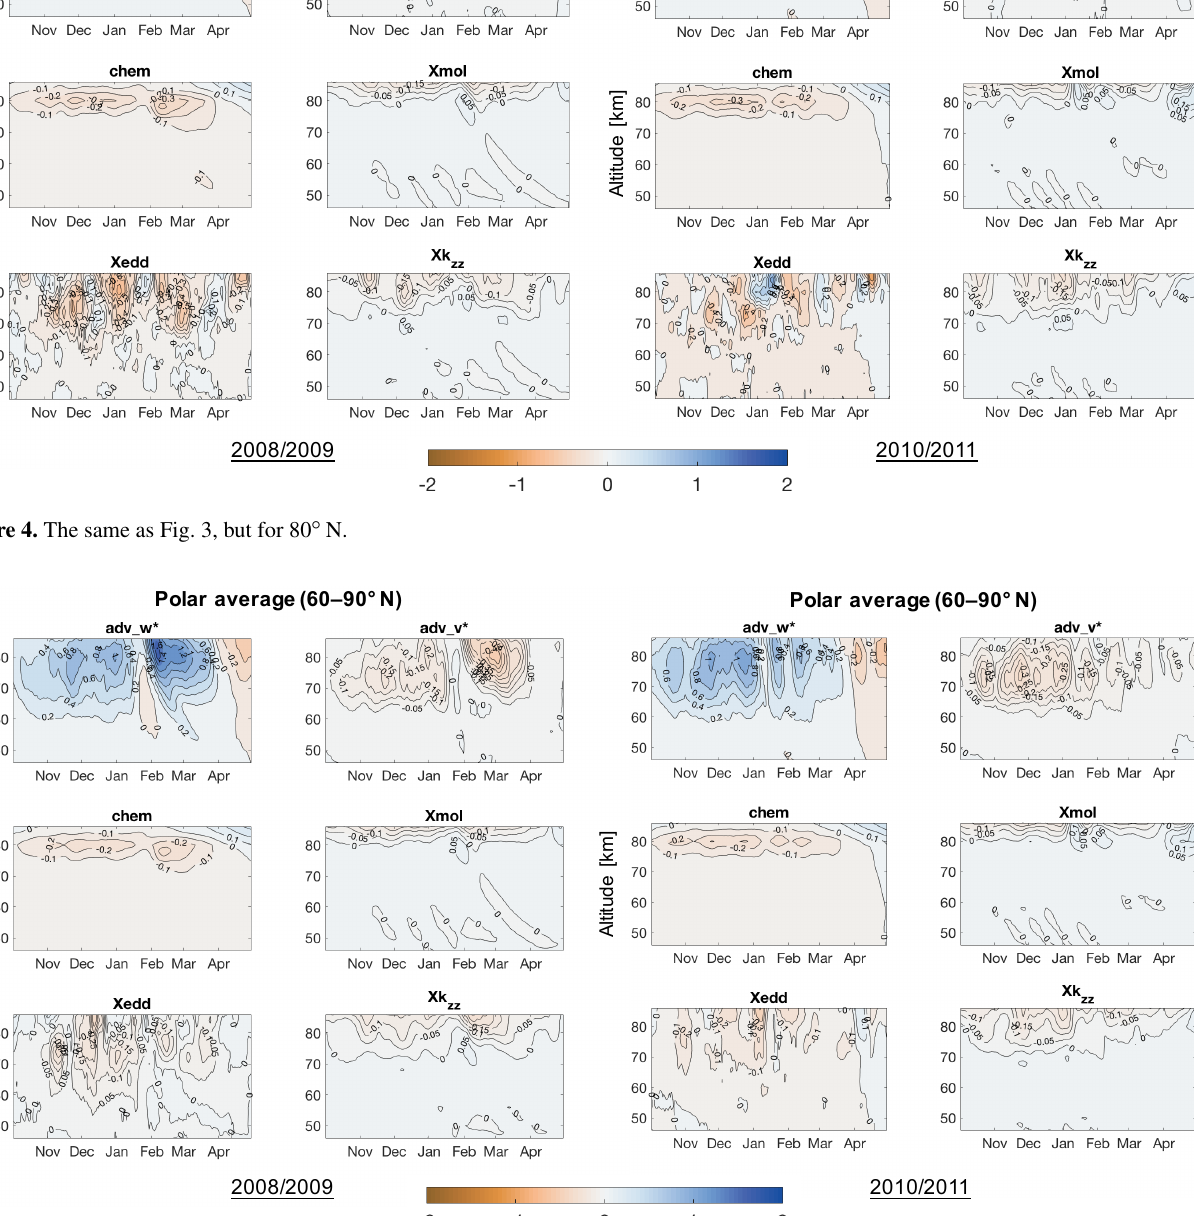
( z) vs. time ( t) . The rate for a given date is calculated here by performing a regression on the CO data within ± 5 days of the date. This gives an 11-day running mean of the rate of vertical motion. The calculation can be done for multiple